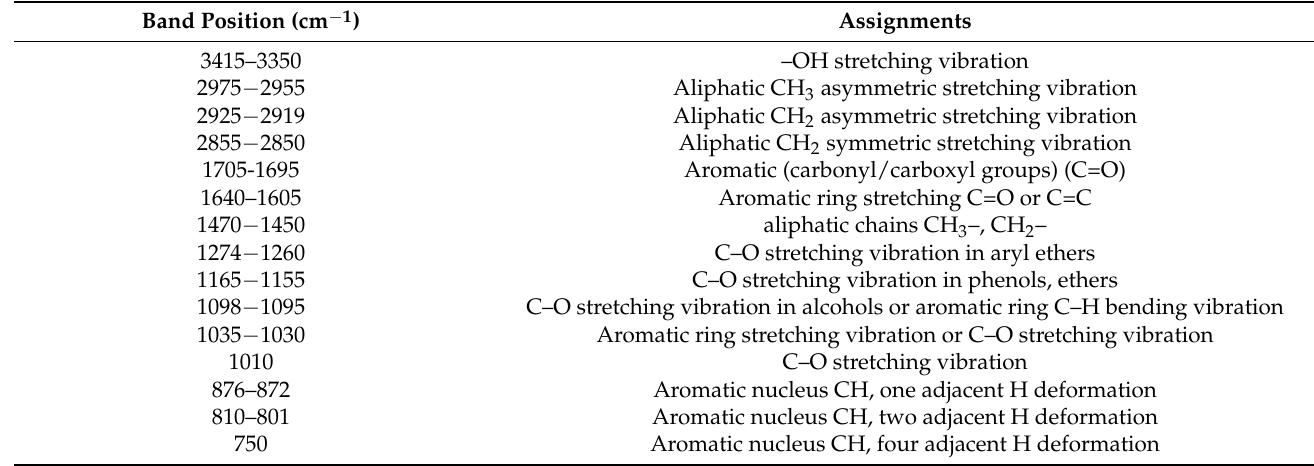
Table 3. Band assignments derived from FTIR